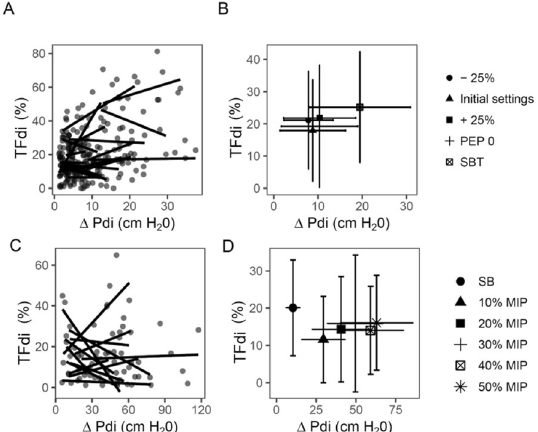
Fig. 1 Intra‑individual relationships between ΔPdi and TFdi for mechani‑ cally ventilated (MV) patients (A) and healthy subjects (C). Relationships between ΔPdi and TFdi when breathing cycles were averaged for all par‑ ticipants during each condition for MV patients (B) and healthy subjects (D). 25%: initial settings minus 25% inspiratory help, 25%: initial set‑ − + tings plus 25% more inspiratory help, PEP 0: zero positive end‑expiratory pressure, SBT: spontaneous breathing trial. Healthy subjects performed spontaneousbreathing (SB) and ventilation against inspiratory threshold at 10, 20, 30, 40 and 50% of maximal inspiratorypressure